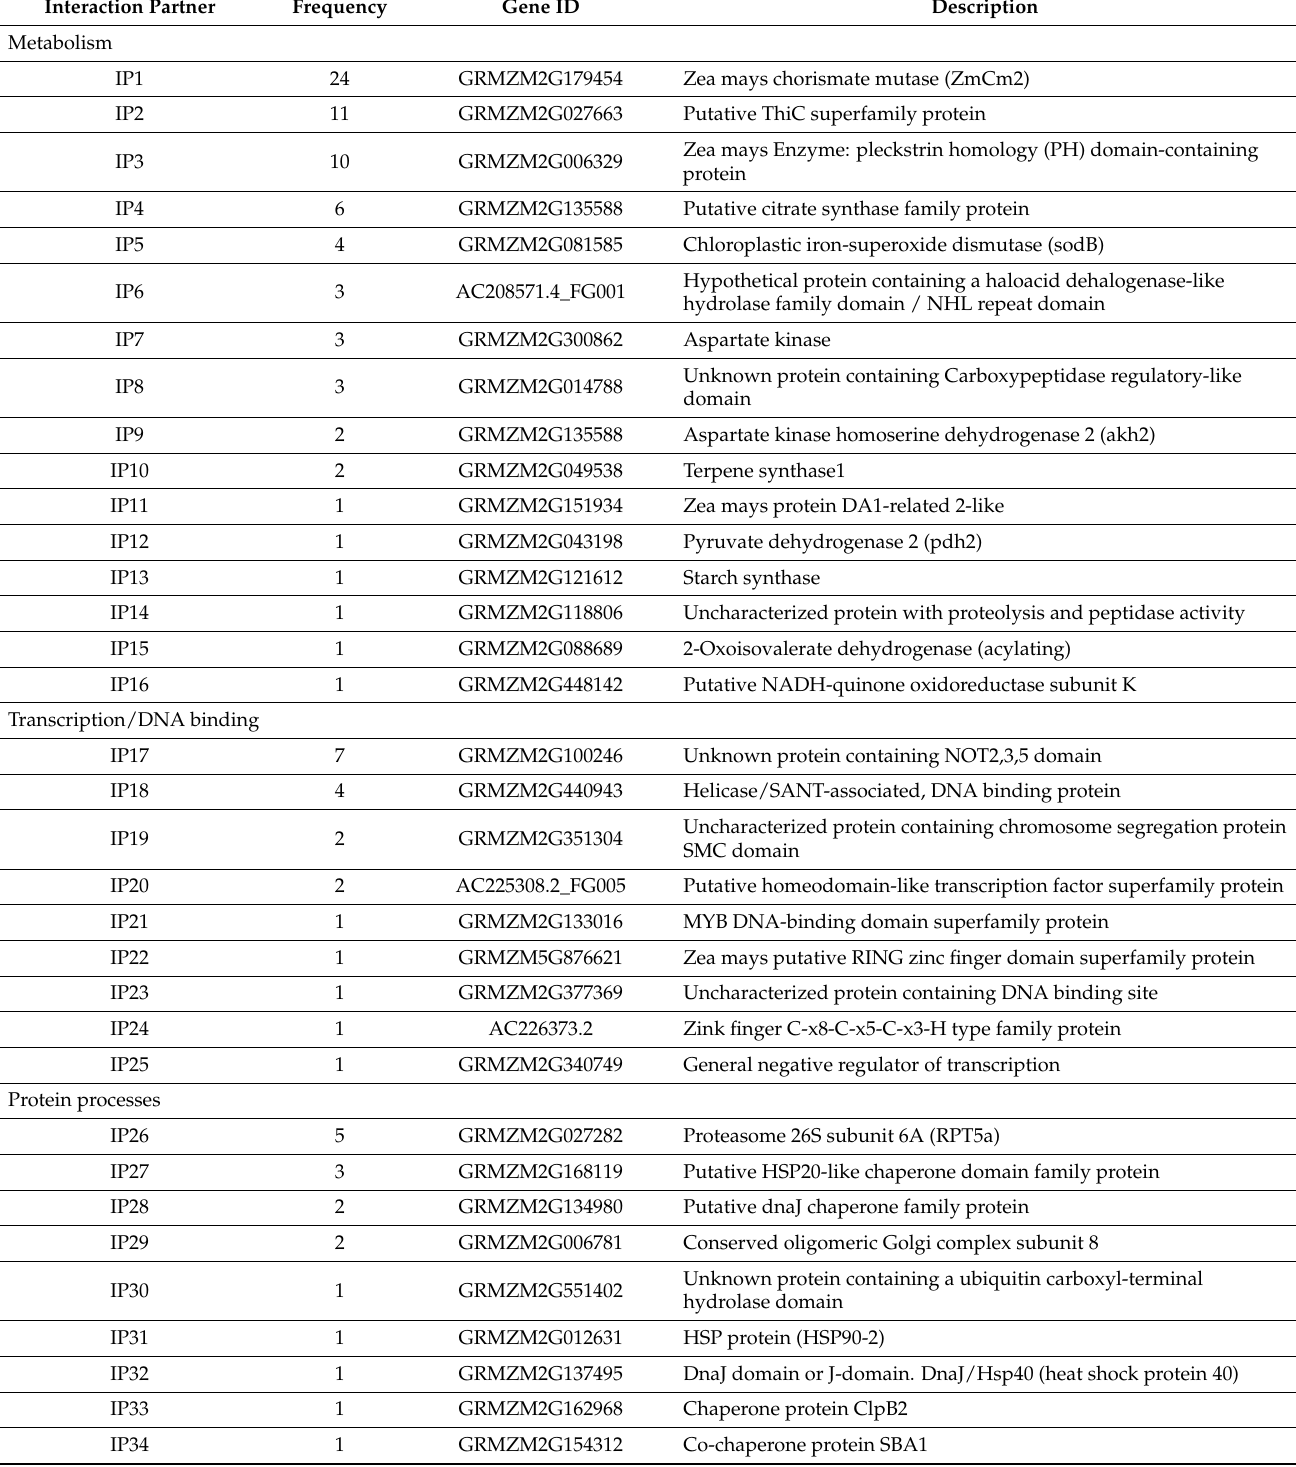
Table 1. List of Vag2 interaction partners identified by yeast two-hybrid screening of a cDNA library generated from S. reilianum -colonized maize